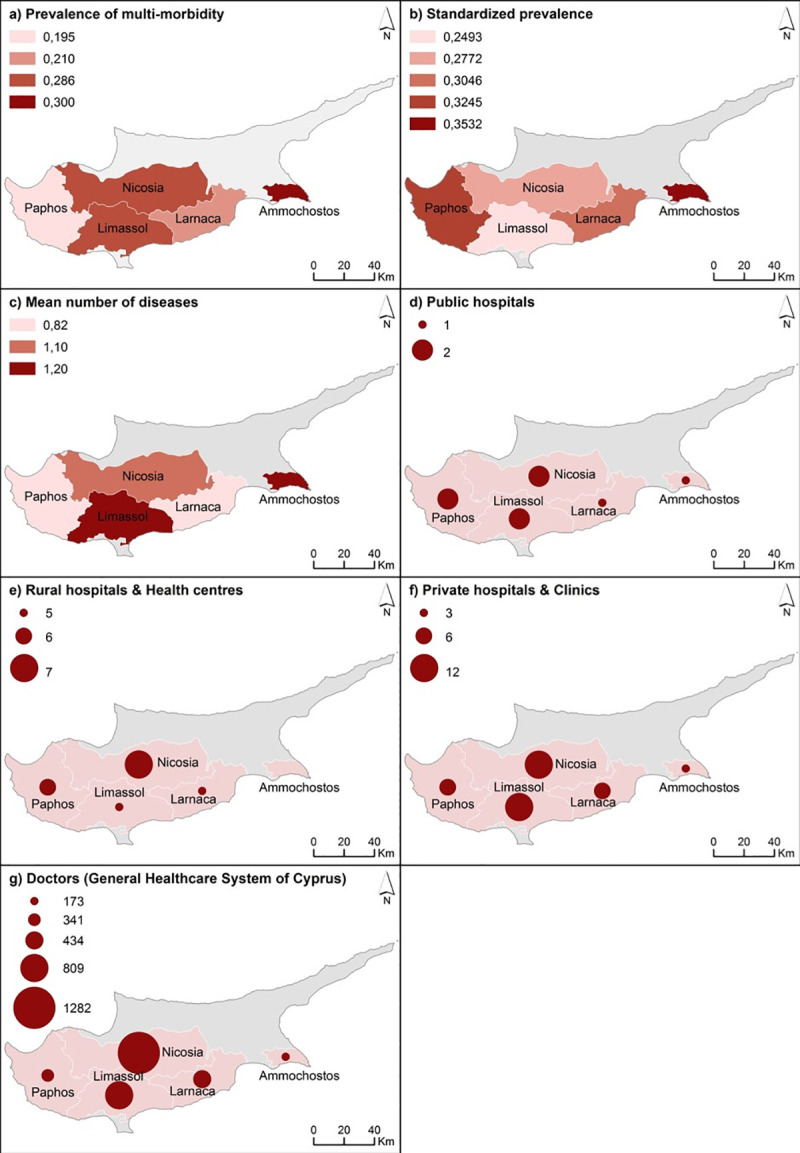
Spatial analysis of multi-morbidities by region of residence and level of urbanicity.